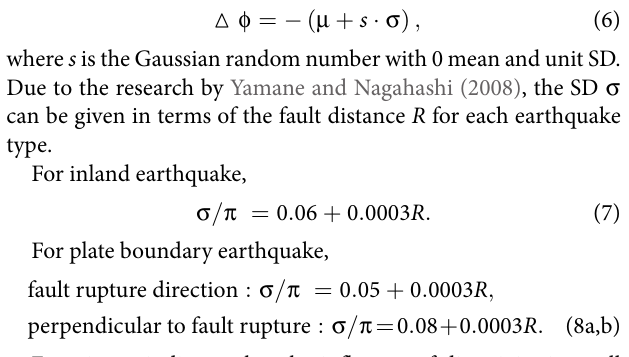
seismic moment M 0 is related to the moment magnitude M